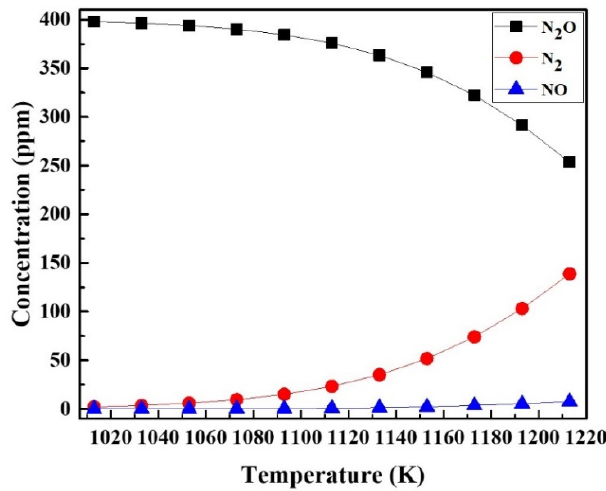
Figure 4. Dependence of the calculated gas concentration on the temperature .